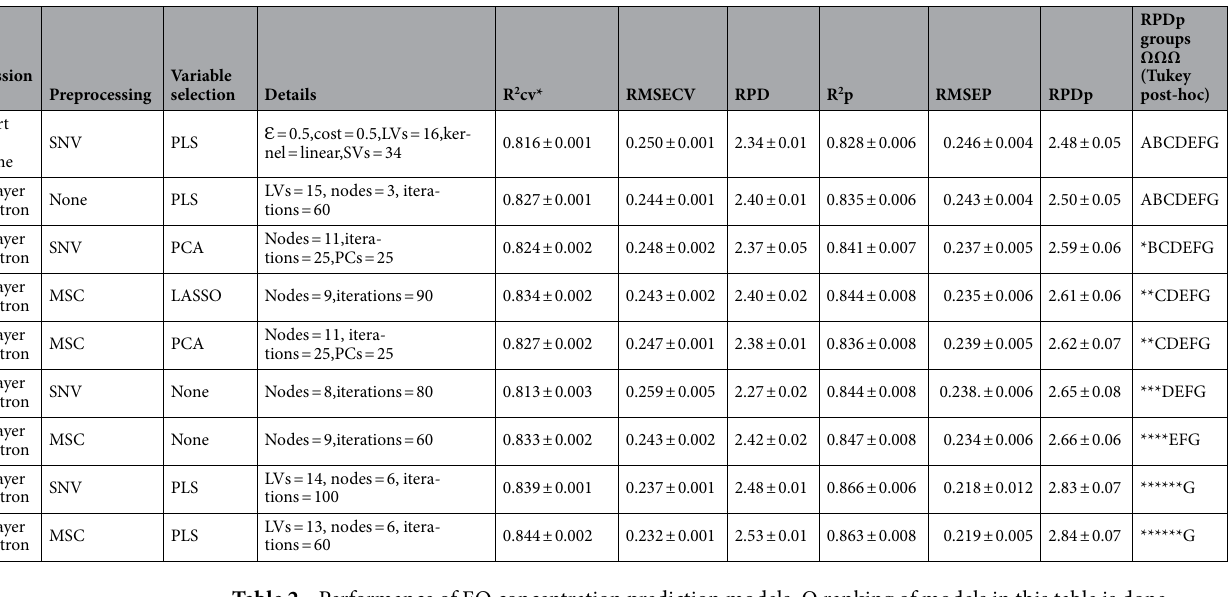
Table 2. Performance of EO concentration prediction models. Ω ranking of models in this table is done according to increasing RPD, ΩΩ SVs = number of support vectors, ΩΩΩ Different letters denote significant difference according to Tukey post-hoc test,* R 2 cv means R 2 of cross-validation, R 2 p means R 2 of holdout validation, ** standard